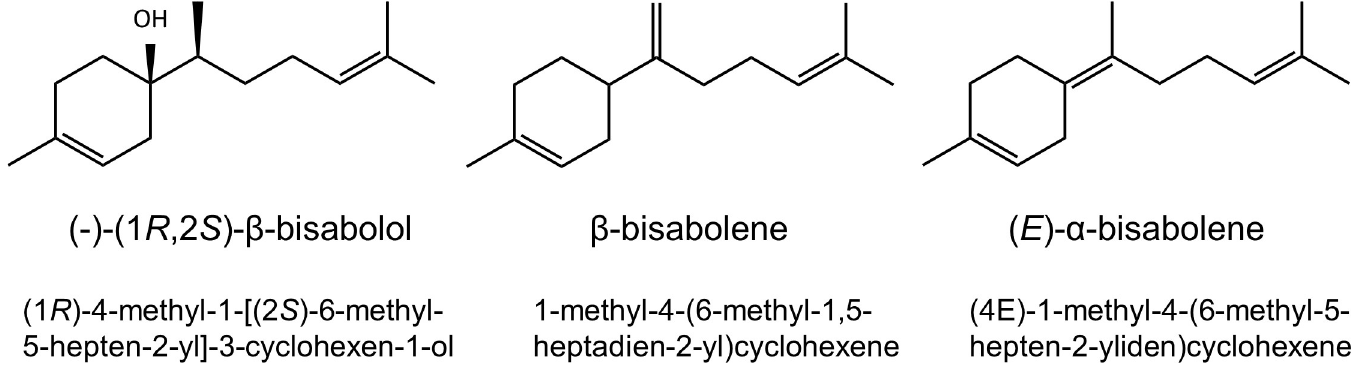
Fig 1. Structures and names of the major sesquiterpenes of S . commune